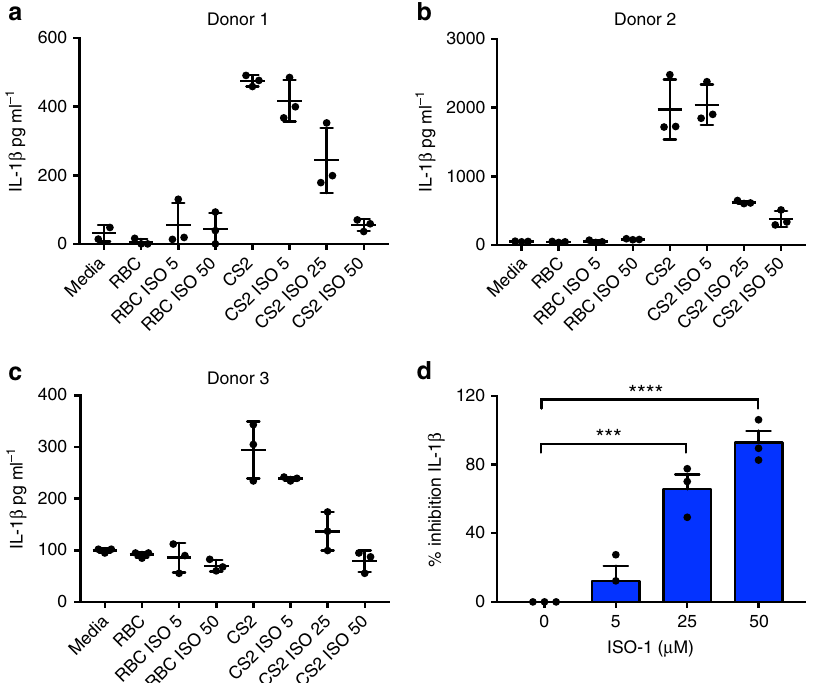
Fig. 3 ISO-1 inhibits IL-1 β in response to Plasmodium falciparum . a – c Viable human PBMCs collected from three donors were co-cultured with 2 × 10 6 non- infected or CS2-infected RBC. Cells were either treated with DMSO alone (control) or with increasing concentrations of ISO-1 (5, 25, or 50 µ M) for 16 h. Levels of IL-1 β in cell culture supernatants were quanti fi ed by ELISA. d Percentage inhibition calculated for all three donors ± SEM *** P < 0.005, **** P < 0.001, one-way ANOVA with a correction provided by the Tukey's multiple comparisons